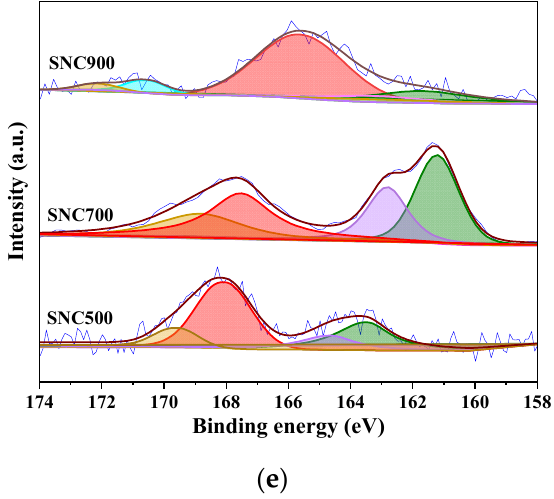
Figure 7. XPS full spectrum ( a ) and C 1s ( b ), N 1s ( c ), O 1s ( d ), and S 2p ( e ) spectra of SNC. Table 1. Content and composition of C, N, O, and S elements at different carbonization temperatures measured by XPS test.